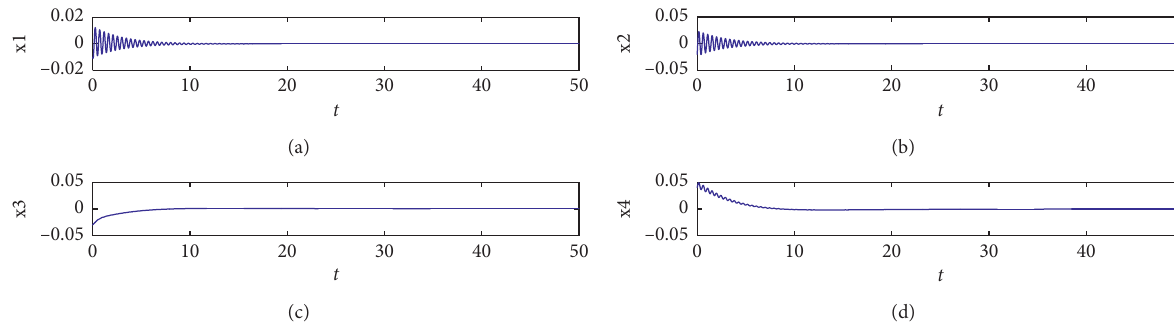
Figure 7: Asymptotical stabilization of the fractional-order novel hyperchaotic system (37) with α � 1.14 and feedback gain K � (2, − 8, − 3.5, − 1).